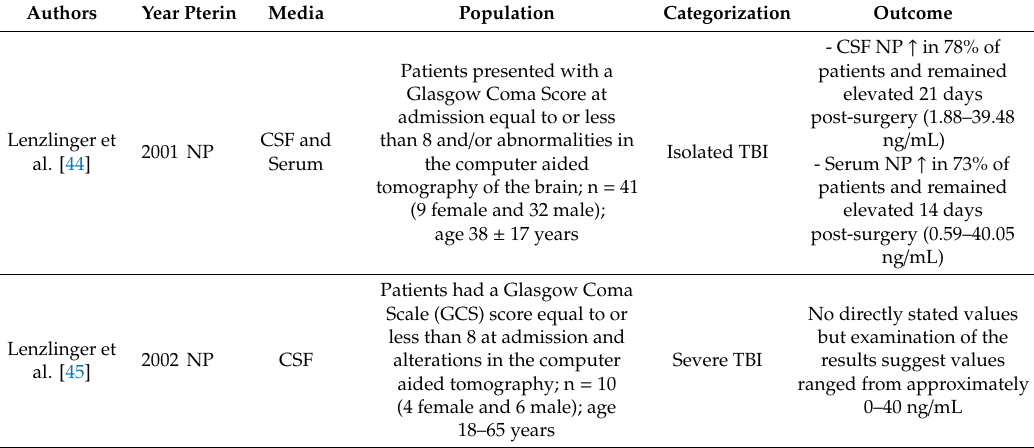
Table 3. Studies measuring pterins following traumatic brain